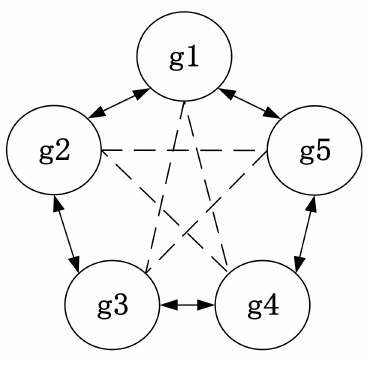
Figure 5. Communication and observation from the network topology under ideal communication